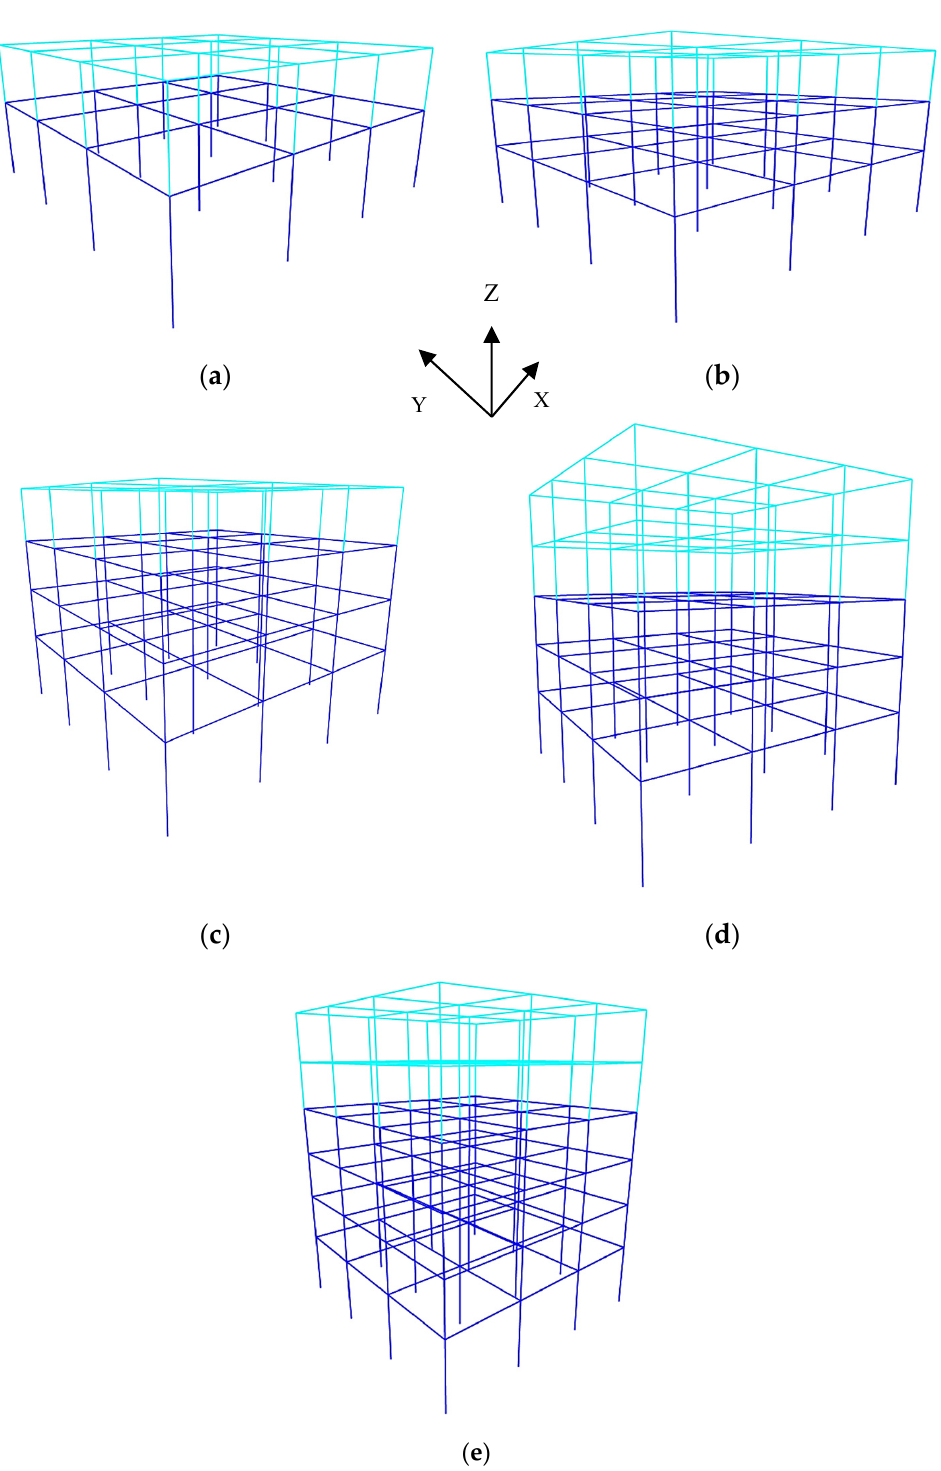
Figure 1. ( a ) Two-, ( b ) three-, ( c ) four-, ( d ) five- and ( e ) six-story mixed r/c-steel buildings (lower r/c and upper steel parts shown with blue and cyan colors, respectively).